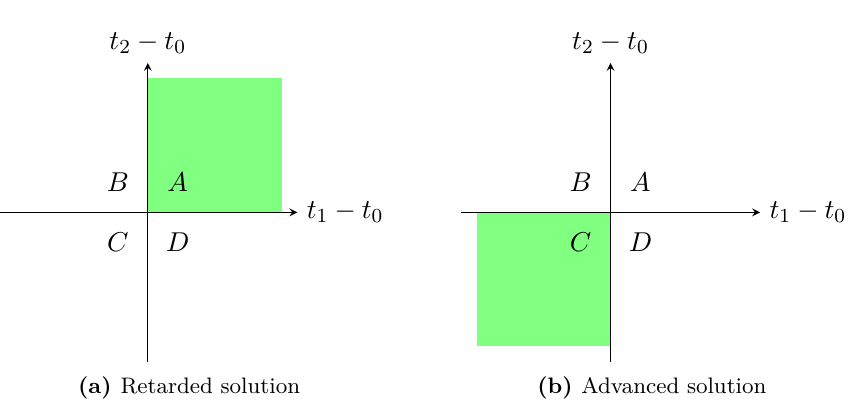
Figure 3. Regions in the ( t 1 , t 2 ) plane for equation (6.8). The green color indicates the region that is affected by the source term. We focus on case (a), the retarded